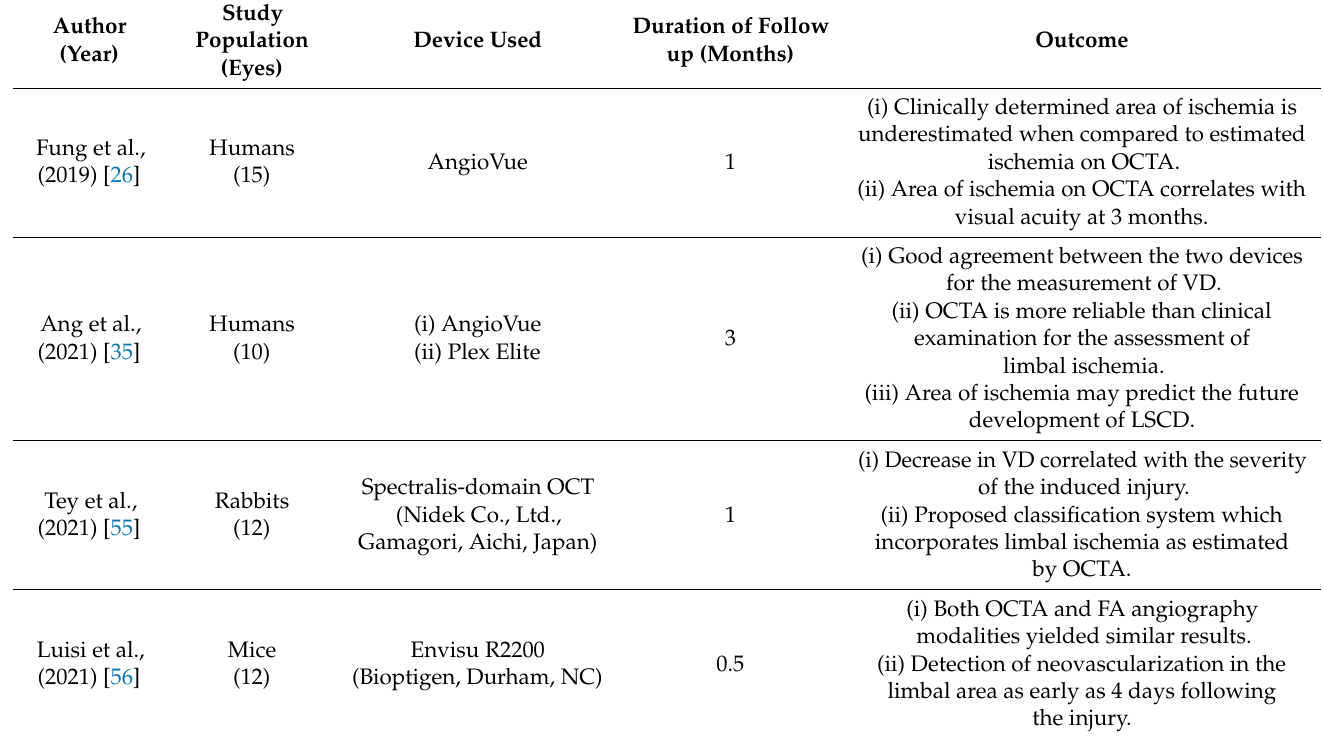
Table 2. A review of studies on the use of AS-OCTA in acute ocular